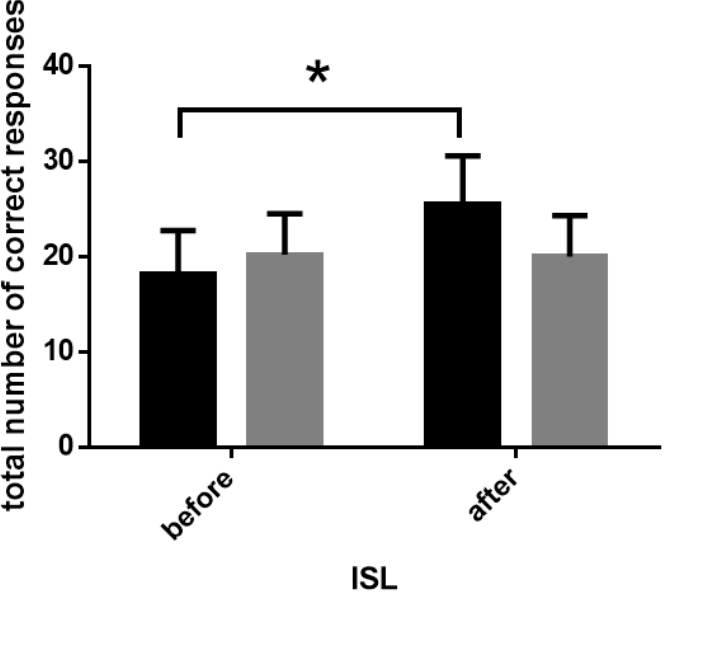
Figure 6. International Shopping List (ISL) scores before and after intervention. Verbal learning and memory function were evaluated by ISL; scores are total number of correct responses. Significant differences between the two groups (P<.001) are marked by the asterisk. CCAT: computerized cognitive addiction therapy.